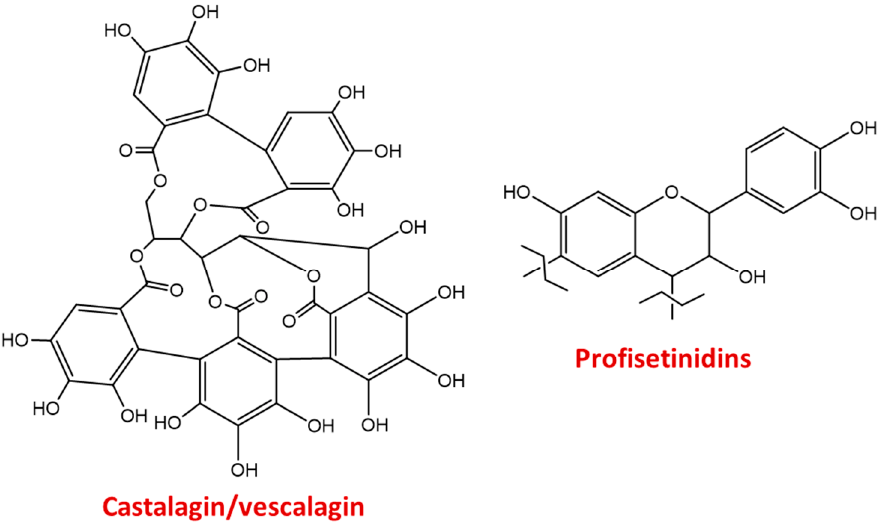
Figure 3. Representative structures of chestnut and quebracho tannins.